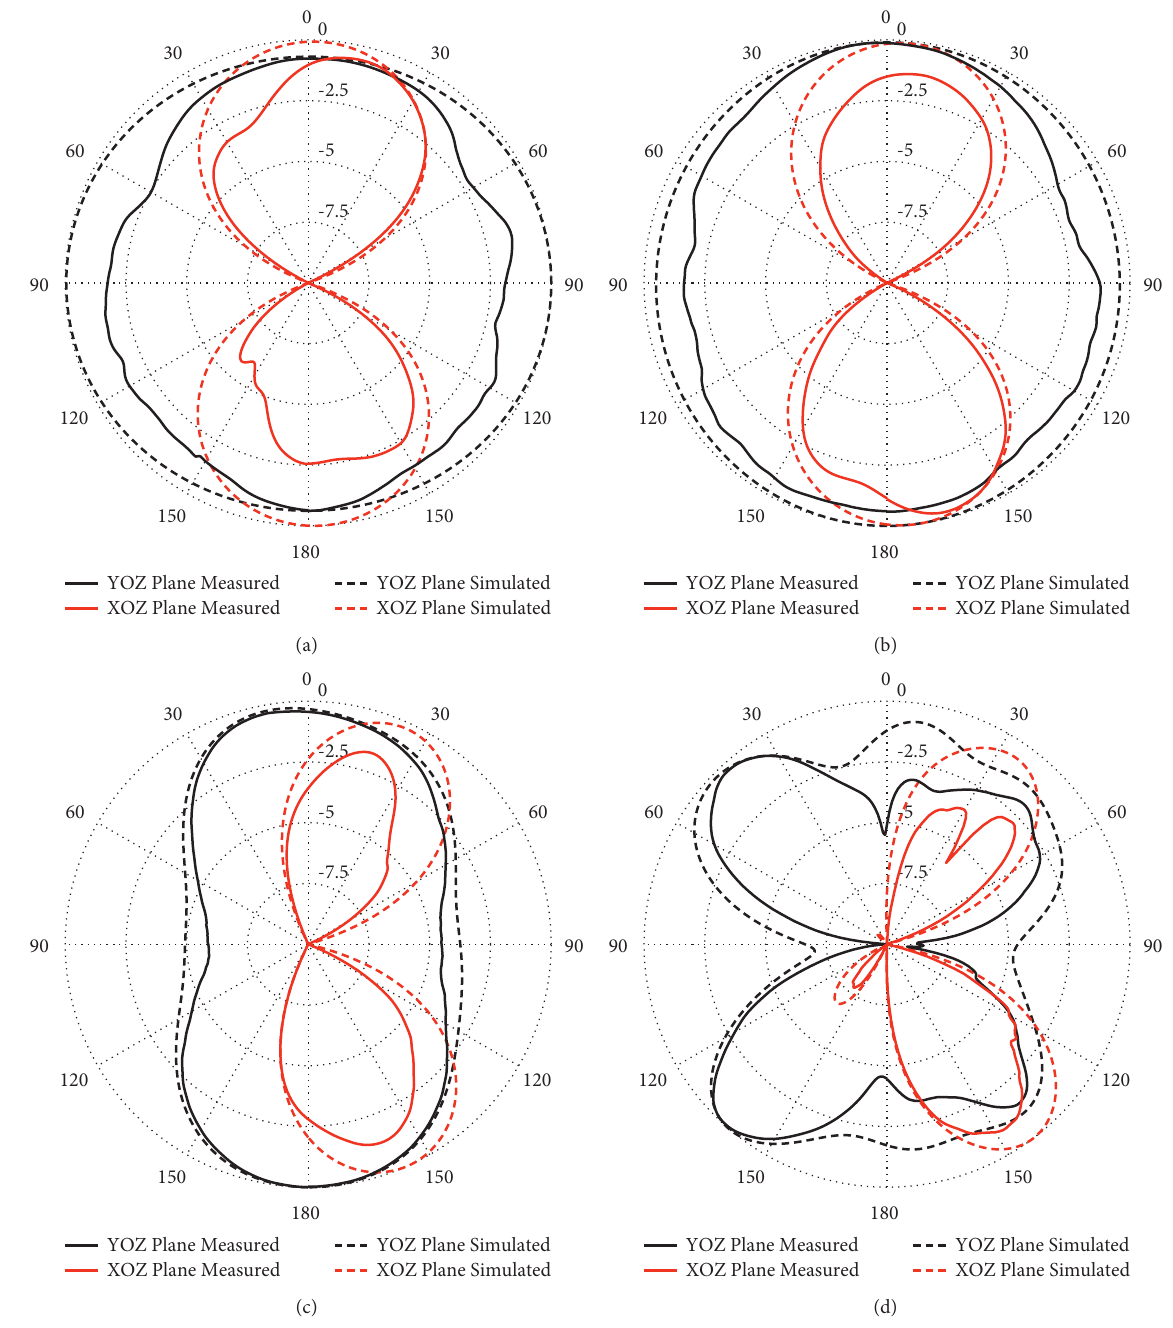
Figure 7: Radiation pattern of the proposed antenna at different resonances: (a) 2.49 GHz, (b) 3.22GHz, (c) 5.23 GHz, and (d) 7.15